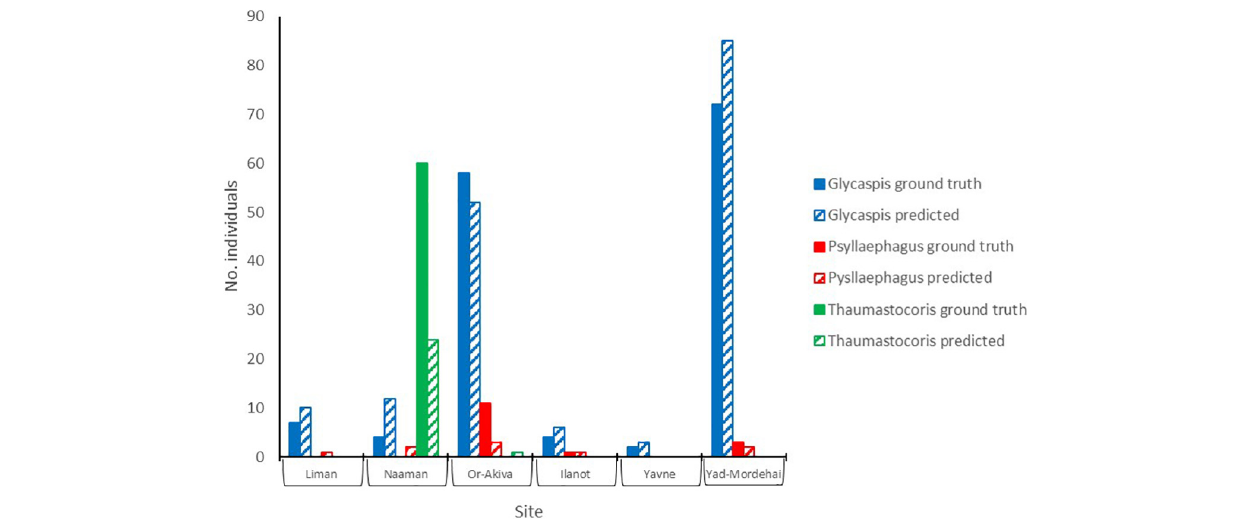
FIGURE 5 | Counts of “Glycaspis” (blue) “Psyllaephagus” (red), and “Thaumastocoris” (green) from sticky traps, as evaluated by a human expert (filled bars) and predicted by the deep-learning model (hatched bars). The traps were placed in six Eucalyptus forests along Israel’s coastal plain in July 2020. Trapping sites are ordered from north to south. See Table 1 for location details and sample